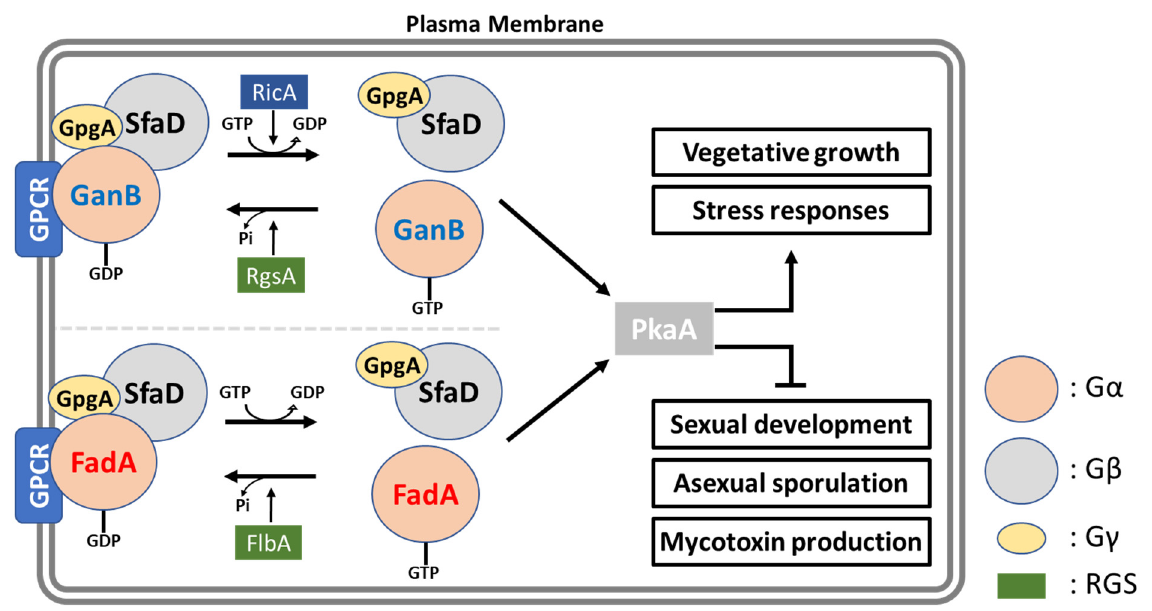
Figure 3. Heterotrimeric G protein-mediated signaling pathway in A. nidulans . In A. nidulans , two G α subunits (FadA and GanB) regulate vegetative growth, development, and mycotoxin production via PKA pathway when they are in the activated state. The regulators of G protein signaling (RGS) FlbA and RgsA turn activated FadA and GanB back into the inactive state, respectively. RicA is a GDP/GTP exchange factor involved in the activation of G protein subunits.